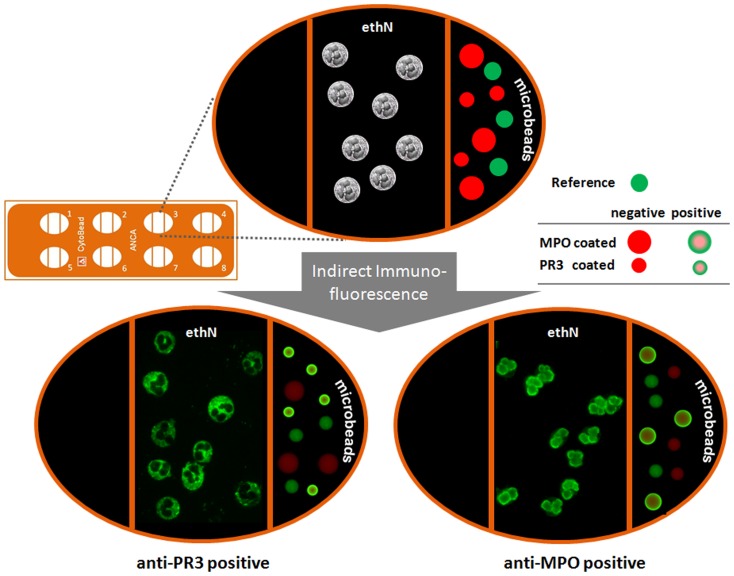
CytoBead ANCA assay principle.Microscopic glass slides with ethanol-fixed human neutrophils (ethN; middle compartment of the well) and proteinase 3 (PR3) as well as myeloperoxidase (MPO) coated microbeads (right compartment of the well) are used for detection of anti-neutrophil cytoplasmic antibodies (ANCAs) by ethN-based indirect immunofluorescence and simultaneous analysis of PR3- and MPO-ANCA by microbead immunoassay. PR3-ANCA positive sera show cytoplasmic fluorescence patterns on ethN and a green fluorescence halo on the surface of PR3-coated microbeads (9 µm). In contrast, MPO-ANCA positive sera show perinuclear fluorescence patterns on ethN and a green fluorescence halo on the surface of MPO-coated microbeads (15 µm).